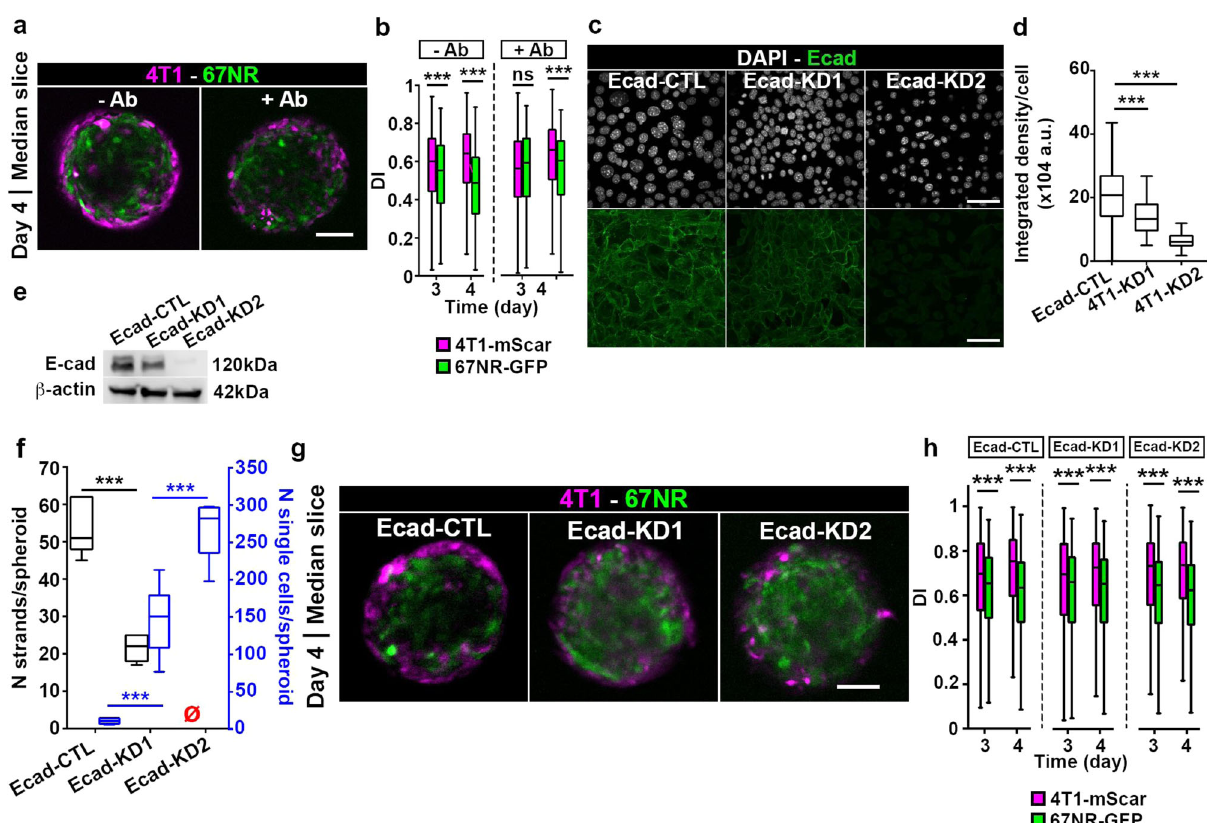
Fig. 3 Disruption of cell-cell adhesions does not affect cell sorting. a Mixed spheroids, at a 1:50 ratio, imaged on day 4 post-embedding. Spheroids were treated with ( + Ab, right panel) or without ( − Ab, left panel) an E-cadherin blocking antibody. Scale bar: 100 µ m. b DI for 4T1-mScar (magenta boxes) and 67NR-GFP (green boxes) cells from spheroids in ( a ). P = 2.78 × 10 − 5 , <2.2 × 10 − 16 and 1.12 × 10 − 12 respectively, by the Wilcoxon rank sum test. c Ecad- CTL, Ecad-KD1 and -KD2 cells in 2D. E-cadherin (green, bottom panels) and nuclei (gray, top panels) are shown. d Integrated density of the E-cadherin signal from cells in ( c ). P = 4.85 × 10 − 12 and <2.2 × 10 − 16 , by the Wilcoxon rank sum test. e Western-blot of E-cadherin expression in Ecad-CTL, -KD1 and -KD2 cells. β -actin is used as a loading control. f Number of strands per spheroid (black) and number of single cells per spheroid (blue) for Ecad-CTL, -KD1 or -KD2 spheroids. The red empty symbols indicate zero values. P = 9.01 × 10 − 10 , 1.06 × 10 − 3 and 1.74 × 10 − 5 , by the t -test. g Mixed spheroids, at a 1:50 ratio, imaged on day 4 post-embedding. Ecad-CTL, -KD1 or -KD2 cells were used. Scale bar: 100 μ m. h DI for Ecad-CTL, -KD1 and -KD2 (magenta boxes) and 67NR-GFP (green boxes) cells from spheroids in ( g ). P = 4.72 × 10 − 5 , <2.20 × 10 − 16 , 2.21 × 10 − 5 , 2.12 × 10 − 15 , 2.05 × 10 − 13 and <2.20 × 10 − 16 , by